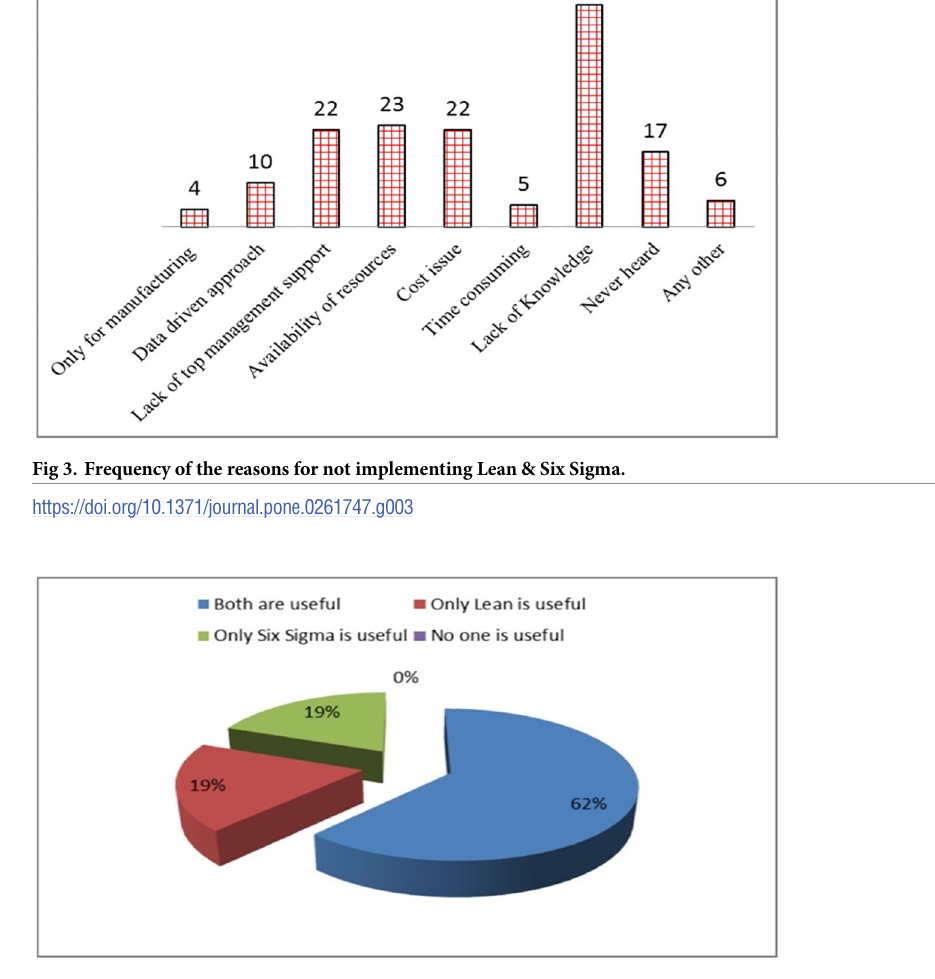
Fig 4. Pie chart showing the usefulness of Lean & Six